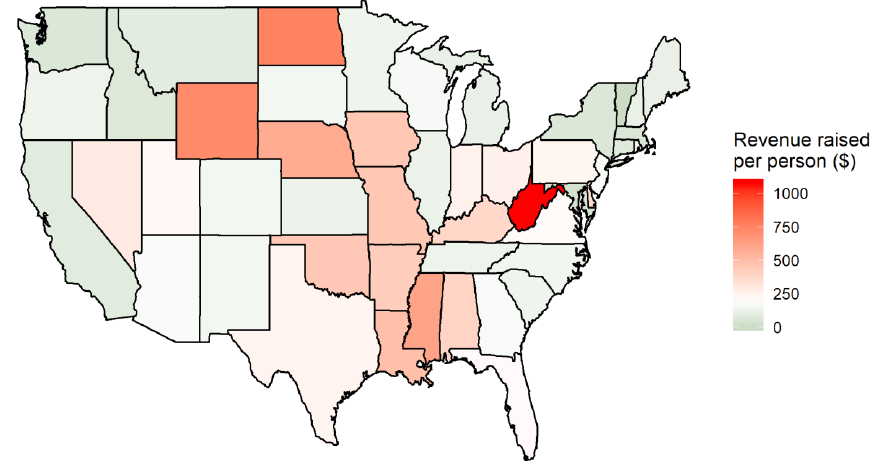
Figure 9. Tax revenue raise by state, $50 / ton scenario, colors scaled to highlight relative wealth transfers caused by a $194 flat tax rebate.